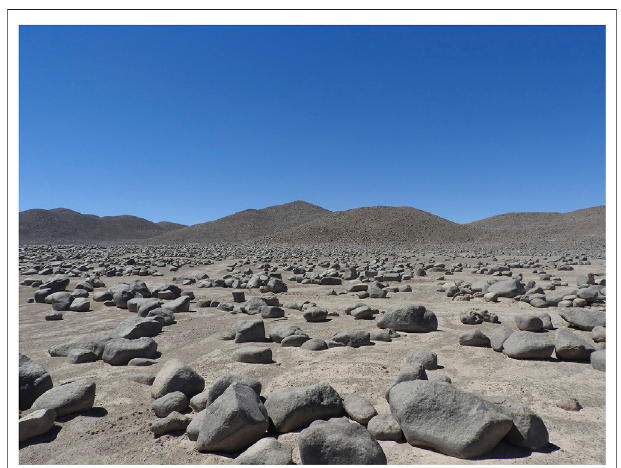
FIGURE 13 | María Elena South. Located in the middle of the hyperarid core and the driest site of the